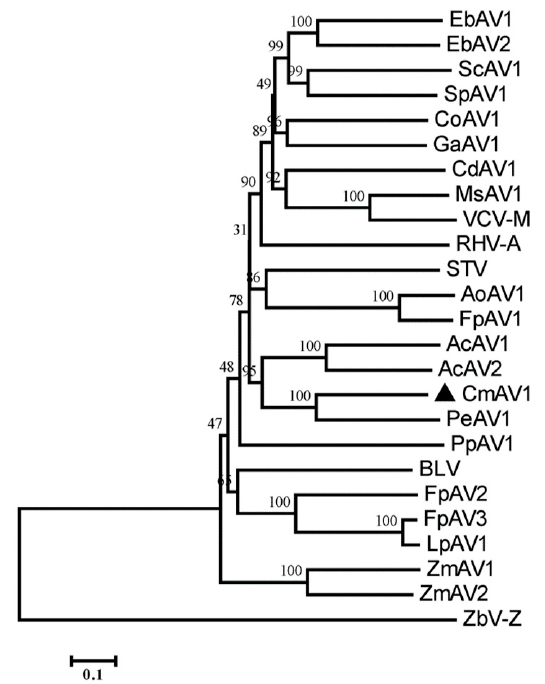
Figure 7. Phylogenetic relationships of CmAV1 and other members of the family Amalgaviridae based on RdRp amino acid sequences.